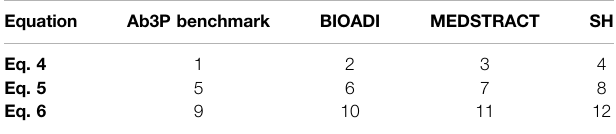
TABLE 8 | Twelve regression models: 1 – 12. The gold labels, y , depend on the columns, and the number of input features, x , depends on the